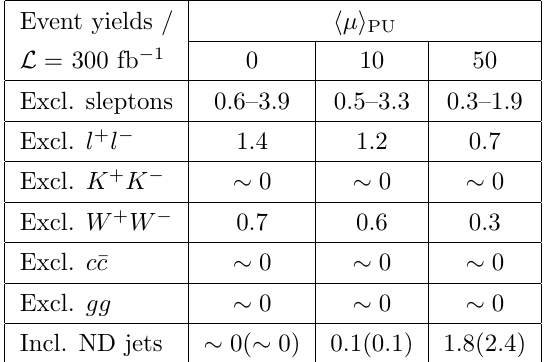
Table 8 . Final event yields corresponding to an integrated luminosity of 300 fb (cid:0) 1 as a function of amount of pile-up events per bunch crossing for the slepton signal and all considered background processes. All numbers correspond to the di-lepton mass range 2 < m l < p T < 40 GeV and a tracker coverage of j (cid:17) j < 2 : 5. The ranges in the signal event yields illustrate the spread obtained from the entire studied slepton mass range: the lower value comes from the ( M ~ ; M ) = (300 ; 280) GeV, the higher from the ( M ~ l e (cid:31) 0 1 marked as (cid:24) 0 corresponds to a number which is su(cid:14)ciently below 0.01. The inclusive ND jet events were generated with Pythia 8.2 ( Herwig 7.1).